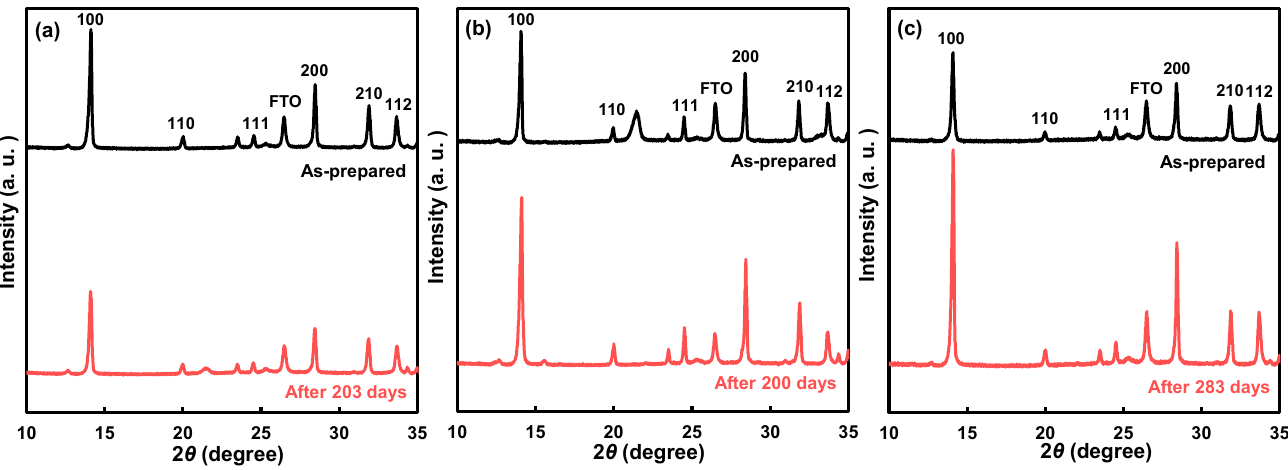
Figure 6. Changes of XRD patterns of ( a ) standard, ( b ) Sn 2%, and ( c ) Sn 2% + Cu 2% devices. Table 6. Structural parameters of the present perovskite crystals. I 100 / I 210 : ratios of (100) diffraction XRD patterns and lattice constants (a) of the standard, +Sn, and +Sn + Cu devices are shown in Figure 6 and Table 6. An intensity of the 100 peak for the Sn 2% added device increased after 200 days, and the crystal orientation of the I 100 / I 210 ratio increased from 2.4 to 2.6, as listed in Table 6. This indicates crystal growth of (100)-oriented perovskite grains after 200 days. In comparison, the I 100 / I 210 ratio for the standard device decreased from 2.5 to 2.1. An intensity ratio of the 100 peak ( I 100 ) to 210 peak ( I 210 ) for the Sn 2% + Cu 2% added device increased further to 3.7 after 283 days. Addition of a small amount of Sn and Cu improved the crystal orientation and suppressed the grain boundaries in the perovskite layer. The crystal growth in the perovskite layer would reduce the trap density between perovskite grains and increase the J SC and η [36]. Figure 7a,b are schematic illustrations of crystal growth of the perovskites and the ionic diffusion in the perovskite, respectively. It is considered that MA and I were desorbed by annealing the perovskite layer during device fabrication. The energy derived from these lattice defects would cause ionic diffusion, which would promote grain growth. Then, the surface coverage and crystal orientation are improved, resulting in an increase in short-circuit current density and conversion efficiency